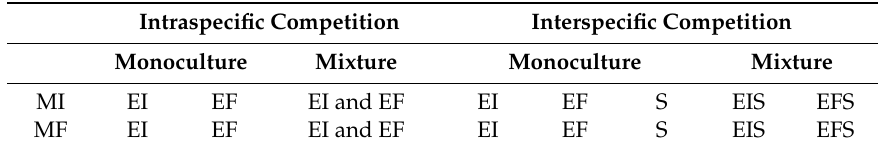
Table 1. The experimental design schematic